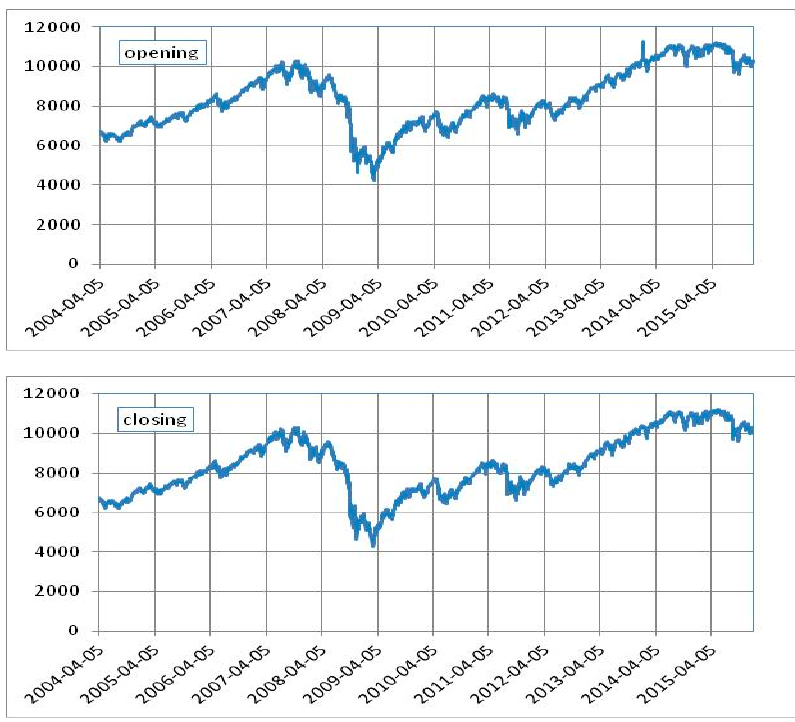
Figure 2. Evolution over time of the values of opening (above) and closing (below) of the NYSE Composite US 100 between 5 April 2004 and 31 December 2015.